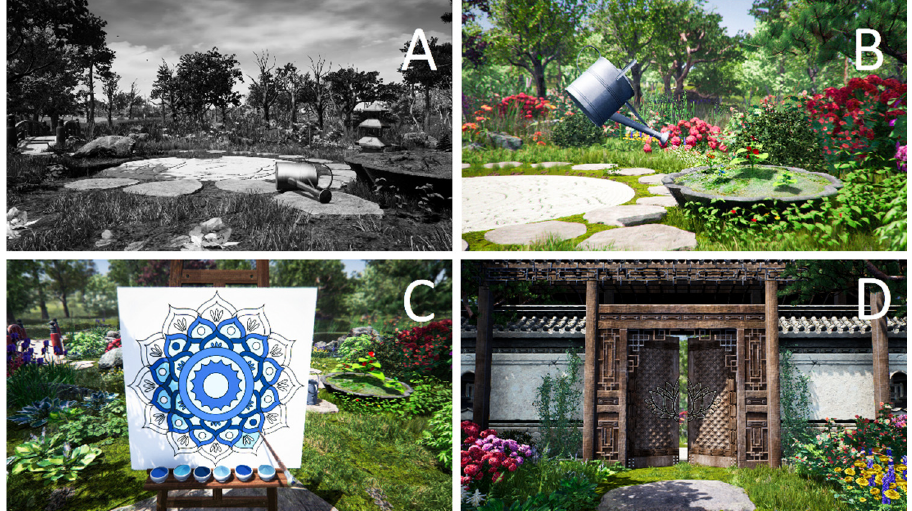
Figure 2. Garden of Revival screen captures: ( A ) initial stage of the therapy; ( B ) final stage of the therapy; ( C ) mandala colouring task; ( D ) gate leading to the Garden of Revival .